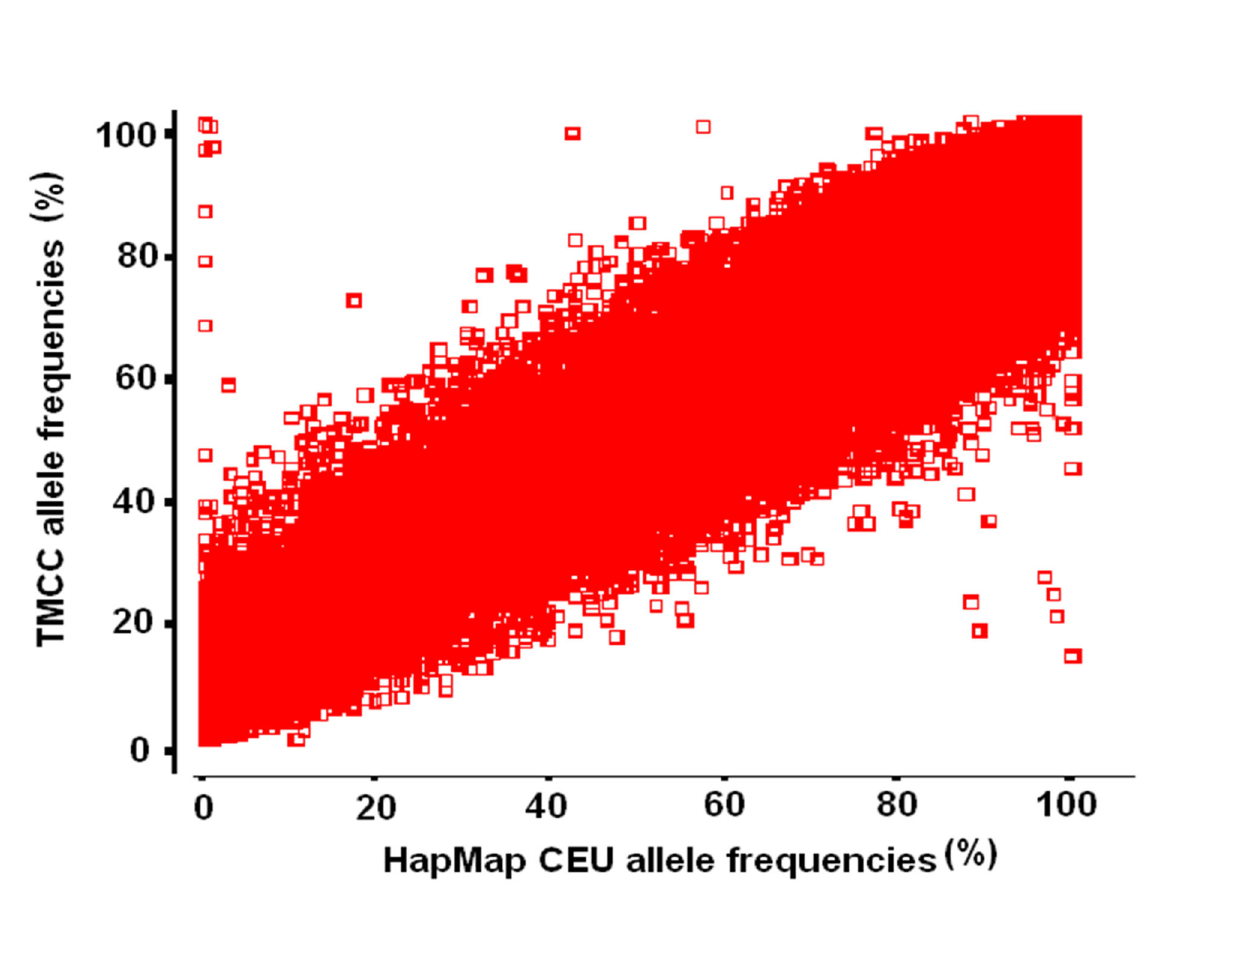
Figure 2. Plot of TMCC vs HapMap CEU